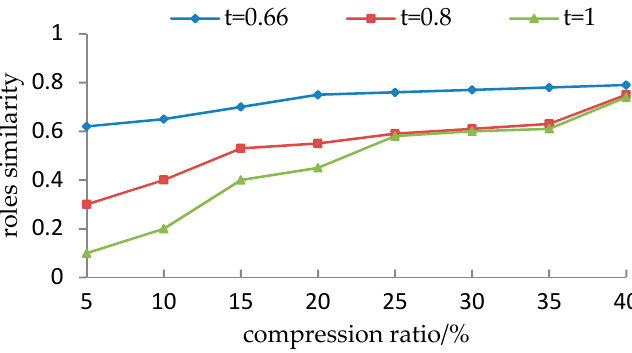
Figure 1. Comparison of sim P ( PA compressed , PA initial ).